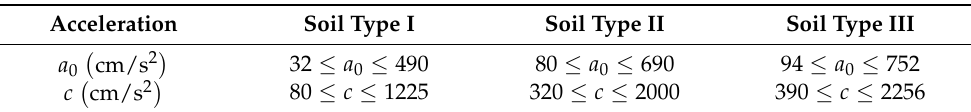
Table 7. Limits for the spectral accelerations a 0 and c , reproduced with permission from Ulises Mena, Comisi ó n Federal de Electricidad Manual de Diseño de Obras Civiles; published by Comision Federal de Electricidad (CFE), 2015